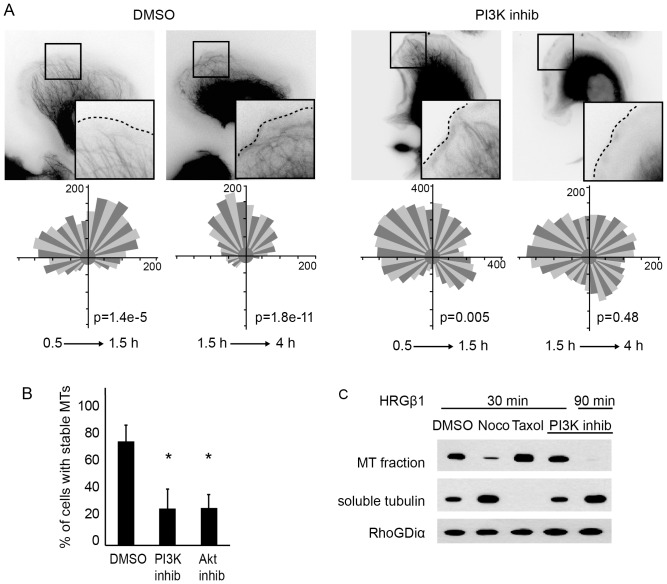
The PI3K pathway controls ErbB2- dependent microtubule stability and chemotaxis.(A) Upper panels: SKBr3 cells expressing EGFP-tubulin were pre-treated with DMSO or the PI3K inhibitor LY294002, before addition of HRG and analysis by time-lapse fluorescence microcopy. Still images, from Video 1, corresponding to early (0.5 to 1.5 h) and late (>1.5 h) time points are shown. Lower panels: Cells loaded on a Dunn chamber were treated as in A, for analysis of the chemotactic response at early time points (0.5 to 1.5 h) or late time points (1.5 to 4 h). Rose diagrams and Rayleigh tests are shown. p>0.05 is considered random migration. (B) The percentage of cells with disassembled microtubules was evaluated. 90–150 cells were counted per condition in three independent experiments; mean+/−s.e.m. is shown; * p<0.01. (C) Cells were pretreated with the indicated drugs, before addition of HRG for 30 or 90 min. Cells were fractionated into microtubule-enriched and soluble tubulin-enriched fractions and tubulin content was analyzed by Western blotting. An anti-RhoGDI antibody was used to assess protein loading. Nocodazole (Noco) and Taxol were used as reference microtubule-destabilizing and -stabilizing drugs, respectively.